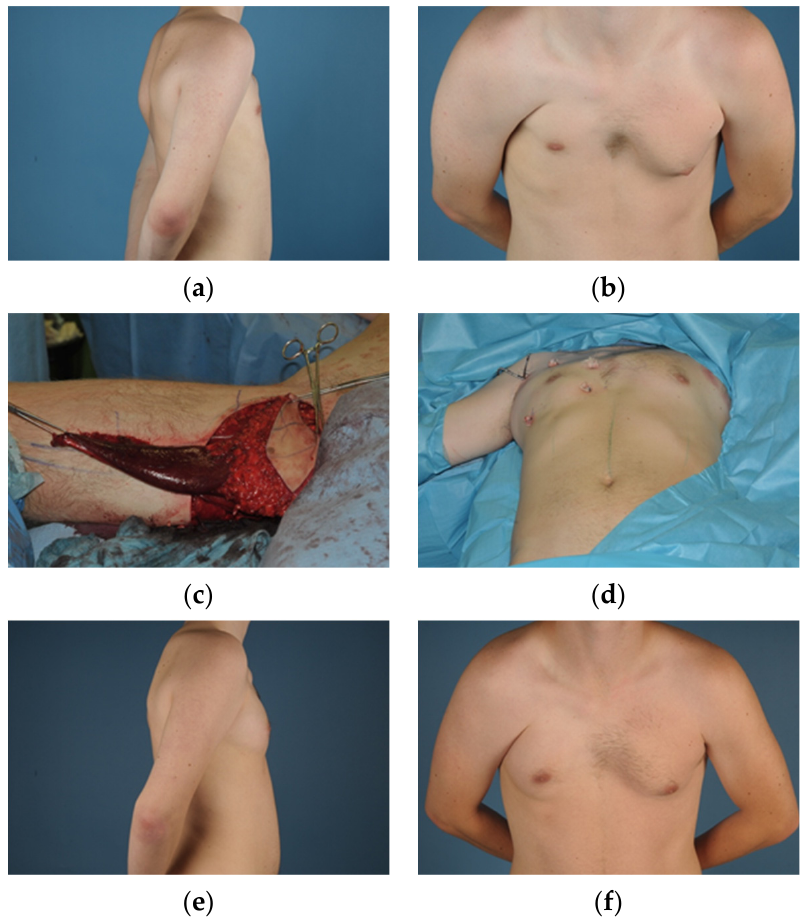
Figure 2. ( a ) = Male patient (21) pre-operatively with Grade III deformity, side view; ( b ) = front view; ( c ) = The ipsilateral TMG is prepared and the muscle resected at the distal insertion; ( d ) = After anastomosis to the thoracodorsal vessels and nerve, the borders of the flap are fixated through the skin; ( e ) = 8 months postoperative, side view; ( f ) = 8 months postoperative front view.